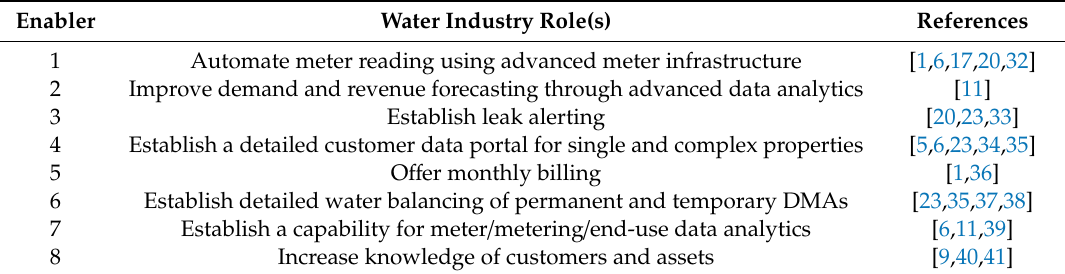
Table 1. The changes required to enable various benefits to be